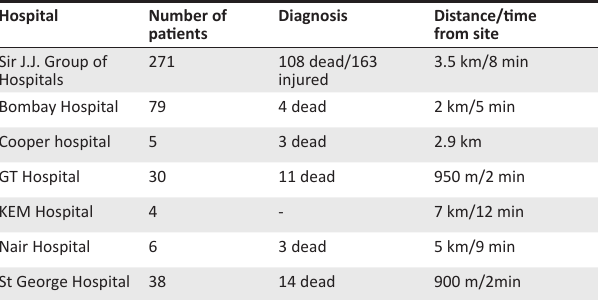
TABLE 2: Detail of the number of patients managed and the distance of the hospital from the disaster